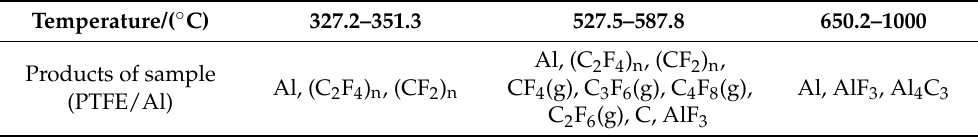
Table 18. Products of Al/PTFE composites in different temperature ranges under argon atmosphere.